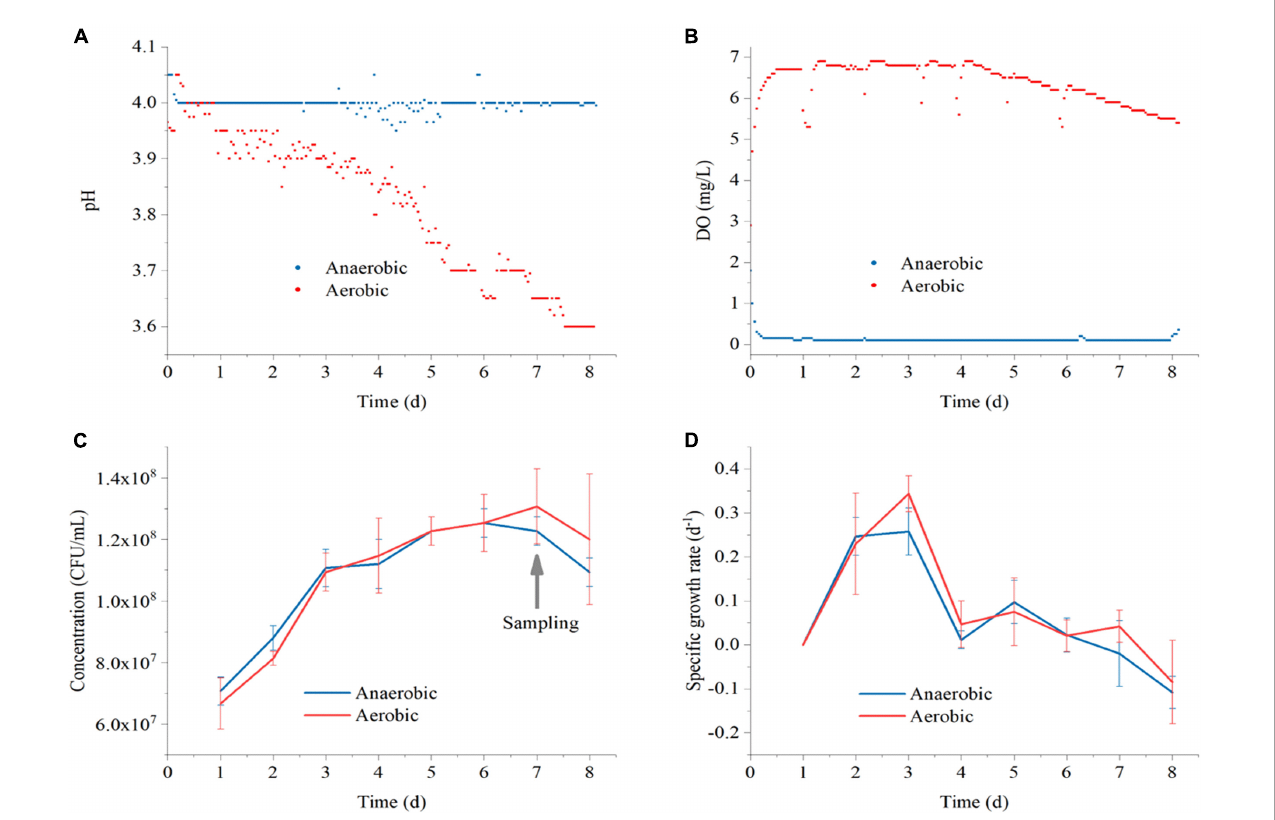
FIGURE2 The real-time values of pH (A) and DO (B) in Polygonati Rhizoma broths fermented by Lactiplantibacillus plantarum under aerobic and anaerobic conditions and the concentration of cells (C) and average specific growth (D) in Polygonati Rhizoma broths fermented by L. plantarum under aerobic and anaerobic conditions. DO, dissolved